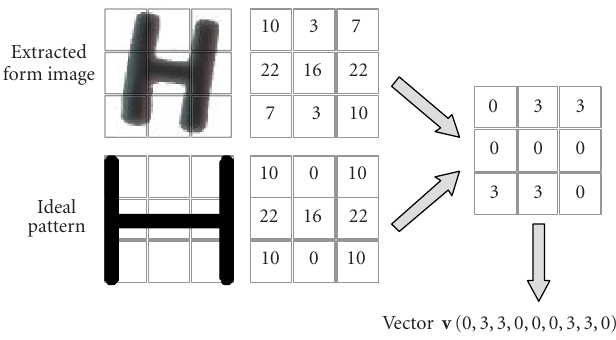
Figure 4: Di ff erence between the ideal pattern “H” and the extracted form